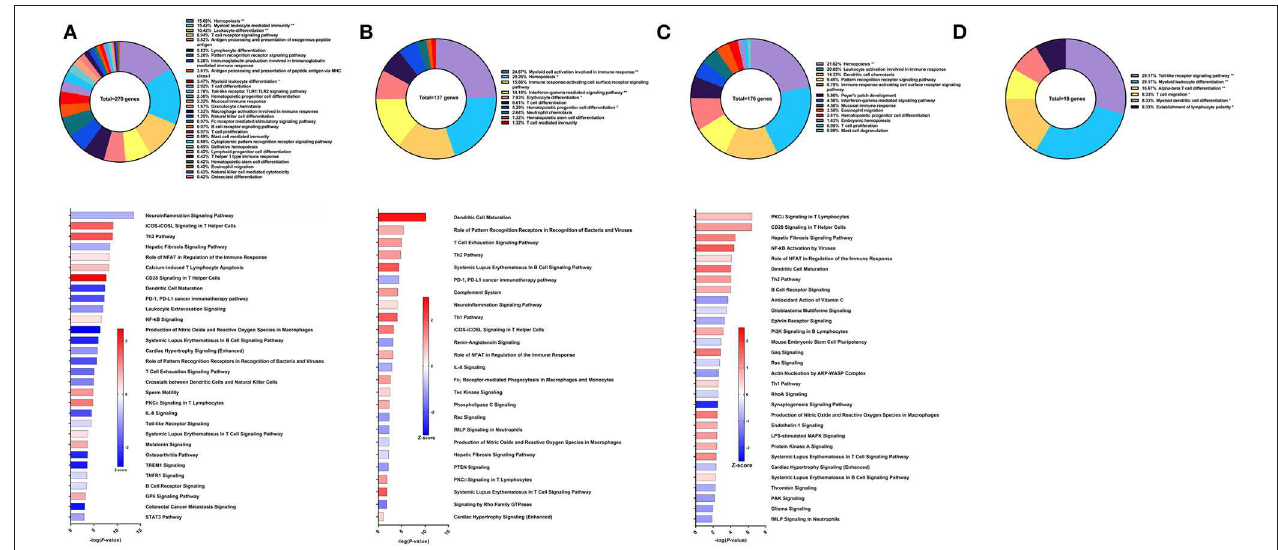
FIGURE 2 | RNA-Seq analysis of Sm-p80-VR1020, a DNA vaccine strategy. (A) PBMCs after vaccination (Top) Gene ontology enrichment analysis represented as a pie graph of percentages of genes per group out of a total number of differentially expressed genes. “**” and “*” indicates P < 0.05 and P < 0.01, respectively. (Bottom) Canonical pathway analysis generated using IPA. Bars are plotted based on the – log10( P -value) and colored based on predicted activation (red) and deactivation/inhibition (blue) according to the Z-score, a composite assessment based on the degree of overlap between directional expression of genes from the observed data and the Qiagen-curated public database. The top 30 pathways are shown based on the lowest P -values. (B) PBMCs after challenge (Top) Gene ontology enrichment analysis. (Bottom) Canonical pathway analysis generated using IPA. (C) Spleen cells (Top) Gene ontology enrichment analysis. (Bottom) Canonical pathway analysis generated using IPA. (D) Mesenteric lymph node cells (Top) Gene ontology enrichment analysis. Bottom) Canonical pathway analysis generated using